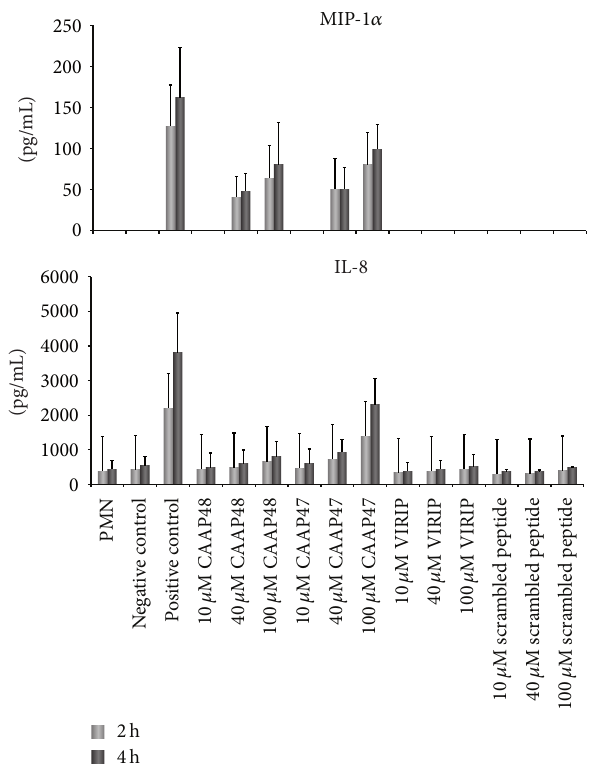
Figure 5: MIP-1 𝛼 and IL-8 concentrations after incubation of PMN with AAT peptides. The concentration of MIP-1 𝛼 and IL-8 in the cell culture supernatant of PMN after peptide stimulation is shown. PMN were incubated with different AAT peptides for two and four hours at concentrations as indicated. MIP-1 𝛼 and IL-8 were quantified by Bio-Plex. Each bar represents the mean ± SD of three independent experiments. The lower limit of detection for MIP-1 𝛼 measurements is 1.6 pg/mL and 1.0pg/mL for IL-8. MIP-1 𝛼 and IL- 8 are released in a dose-dependent manner upon PMN incubation with CAAP47 and CAAP48, while no dose-dependent MIP-1 𝛼 or IL-8 release could be observed upon stimulation with VIRIP or the scrambled peptide compared to the negative control (1x PBS diluted in RPMI 1640 (1:2)). PMA stimulation served as positive